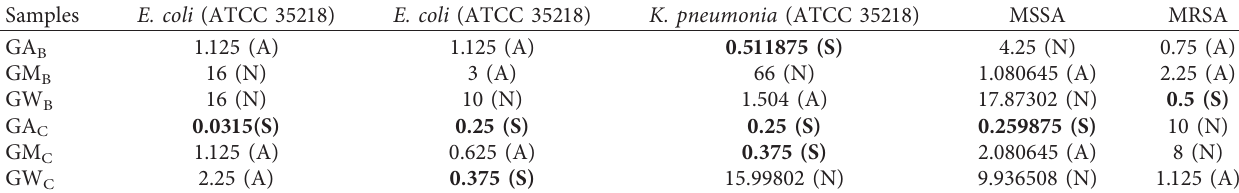
Table 2: Effect of conjugating P. grandiflora tuber extracts with gold nanoparticles.